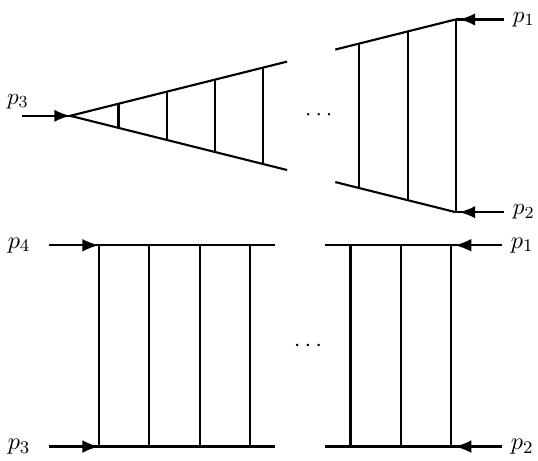
Figure 5 . The L -loop triangle and box ladder integrals. We take all momenta incoming with p 3 along the long direction of the triangle. For the box ladders, s = ( p 1 + p 2 ) 2 and t = ( p 2 + p 3 ) 2